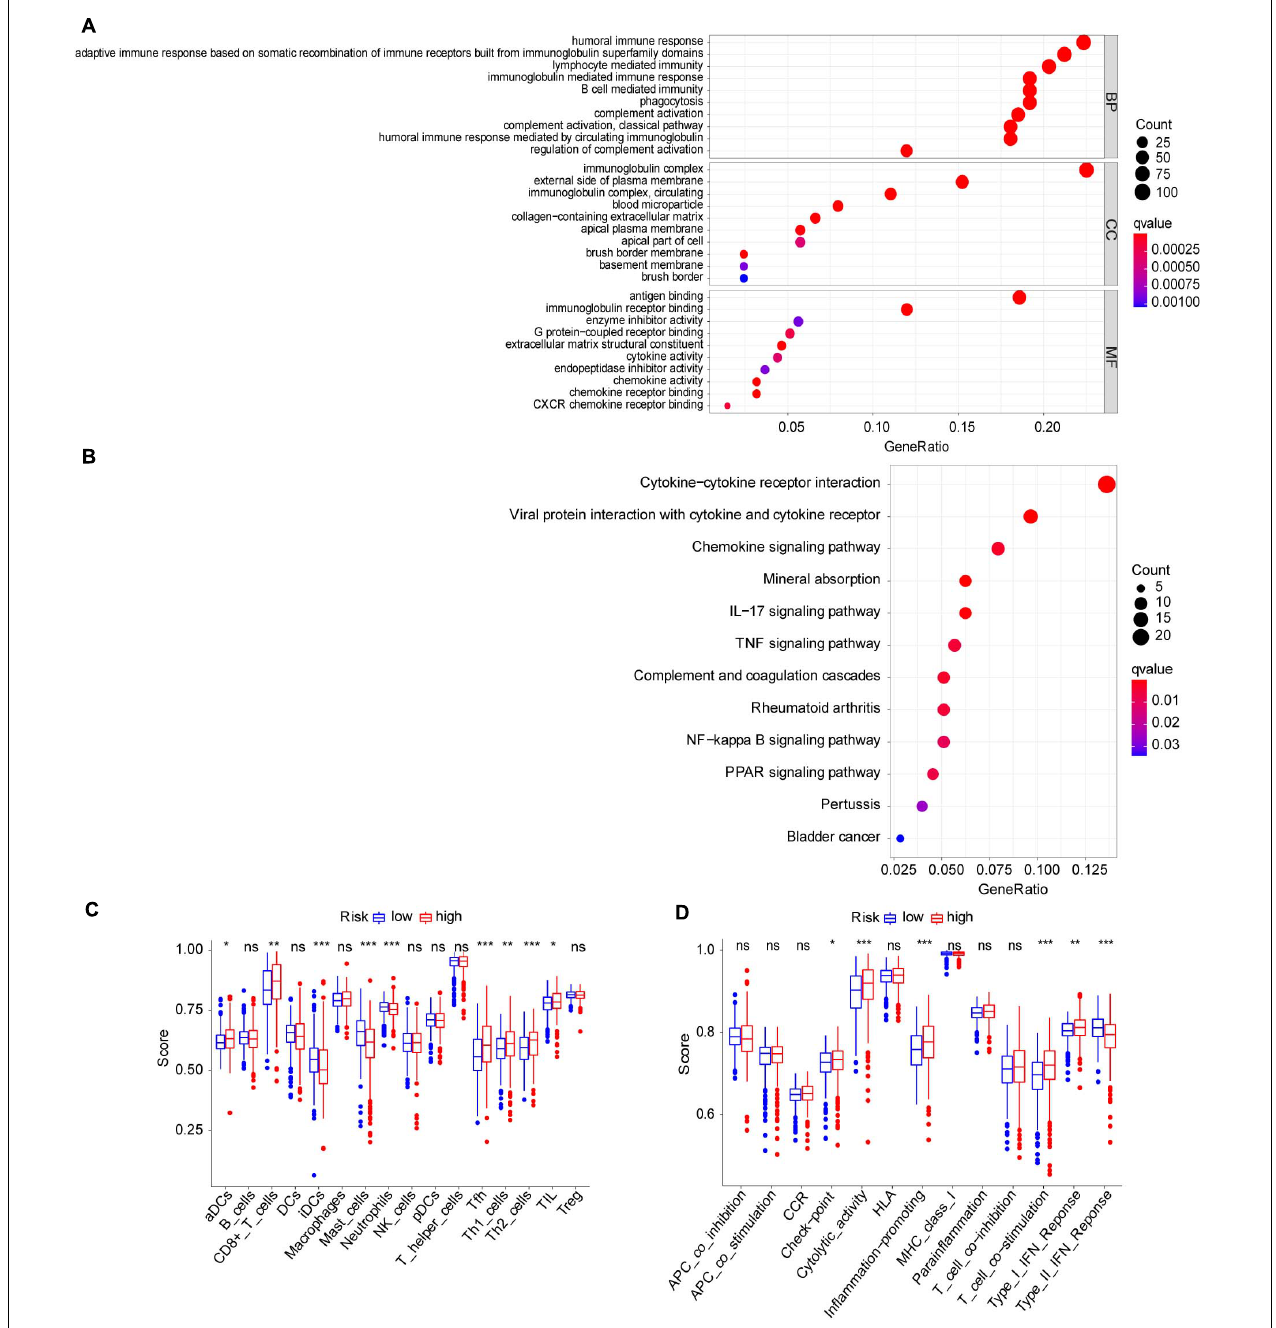
FIGURE 4 | Molecular mechanism and immune infiltrate analysis of ferroptosis-related genes (FRGs) in clear cell renal cell carcinoma (ccRCC). (A,B) Kyoto Encyclopedia of Genes and Genomes (KEGG) pathway analysis revealed the top signaling pathways represented by the FRGs and FRG-interacting genes. (C,D) Single-sample Gene Set Enrichment Analysis (ssGSEA) of the seven FRGs in The Cancer Genome Atlas (TCGA) datasets. * P < 0.05, ** P < 0.01, *** P < 0.001.